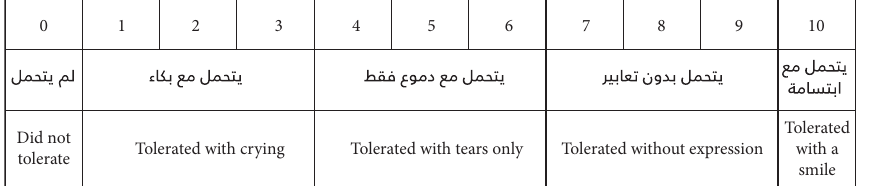
Figure 2: Visual Analogue Scale (VAS) for self-assessment of child’s pain perception (score 0–10) and behavioral/observational pain scale for parent to assess the child’s ability to tolerate pain (score 0–10).